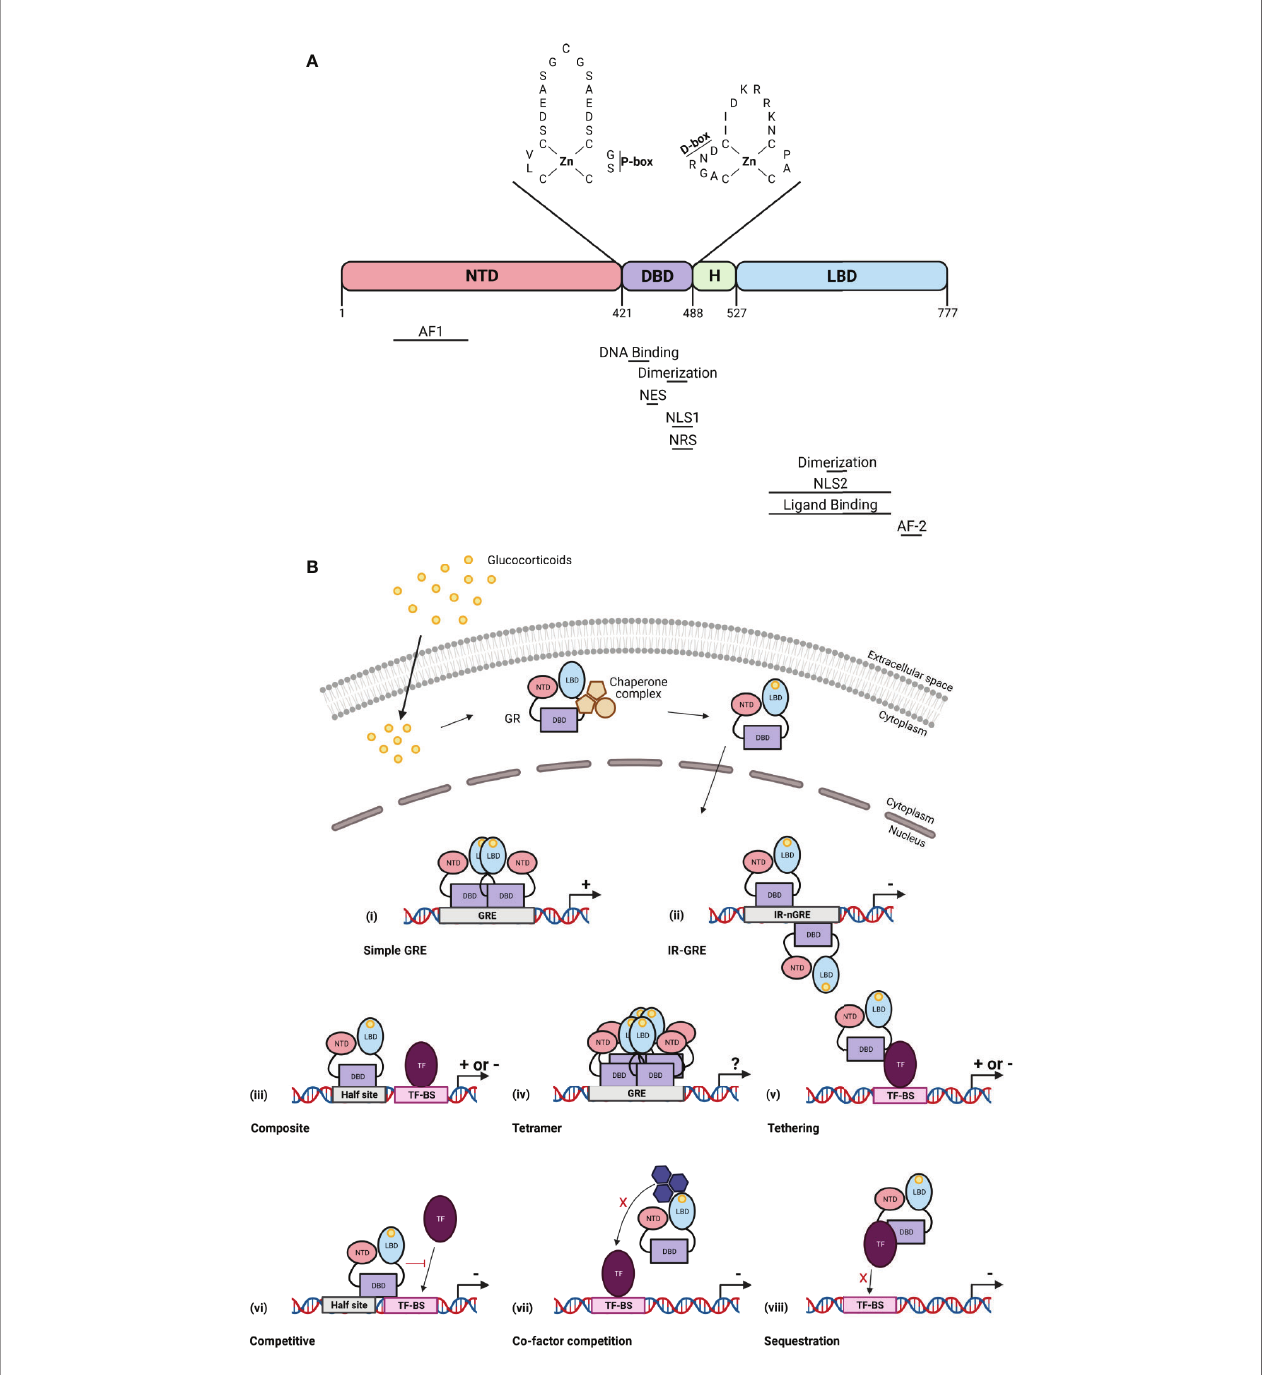
FIGURE 2 | The glucocorticoid receptor (GR) protein (A) and its activation and function (B) . (A) The structure of the GR protein containing an N-terminal domain (NTD), a DNA-binding domain (DBD), a hinge region (H), and a ligand-binding domain (LBD). The DBD contains two zinc fi ngers important for speci fi c GR DNA binding (P box) and GR dimerization (D box). Regions important for the GR function are indicated below the protein structure. AF, activation function; NLS, nuclear localization signal; NES, nuclear export signal; NRS, nuclear retention signal. (B) GCs diffuse through the cell membrane and bind the GR in the cytoplasm. This causes a change in the chaperone complex followed by its release and the translocation of the GR to the nucleus where it induces transactivation (+) or transrepression ( – ) of gene transcription as a GR monomer or a GR homodimer. The GR transactivate gene expression by binding to glucocorticoid receptor element (GRE) as a dimer (i), or can transrepress gene expression by binding to inverted repeat negative GREs (ii). The GR further transrepresses the expression of genes via binding to composite elements (iii), by tethering (v), by competing for DNA binding sites (BS) (vi), by competing for co-factors with other TFs (vii) or by sequestrating TFs (viii). GR can also function as a tetramer (iv), but its function is unknown. Figures created with